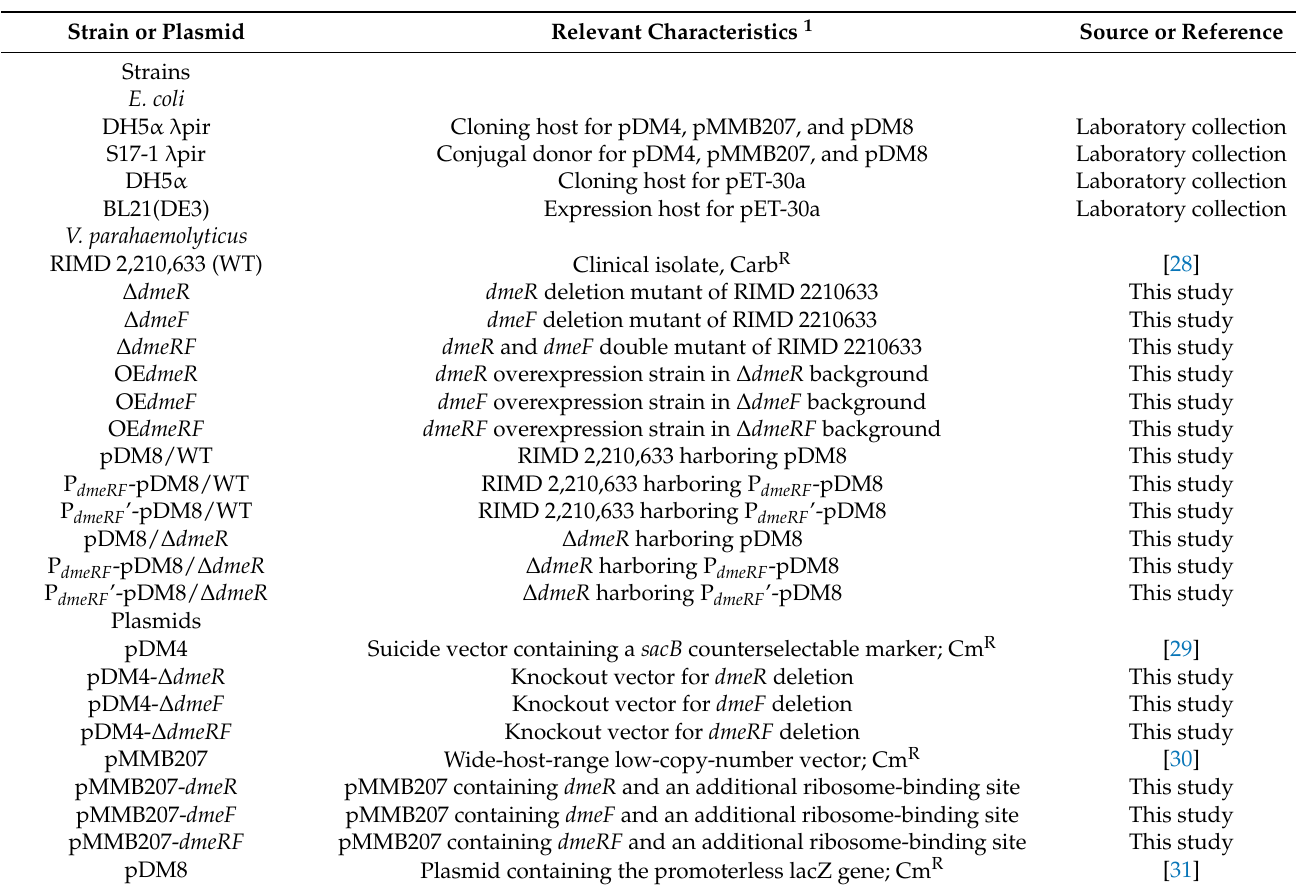
Table 1. Bacterial strains and plasmids used in this